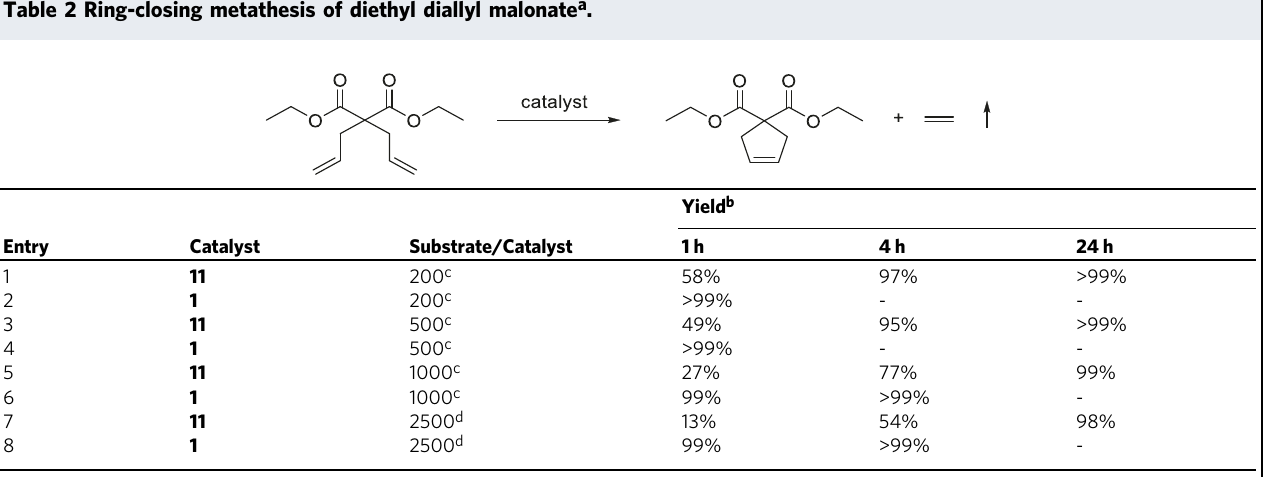
Table 2 Ring-closing metathesis of diethyl diallyl malonate a